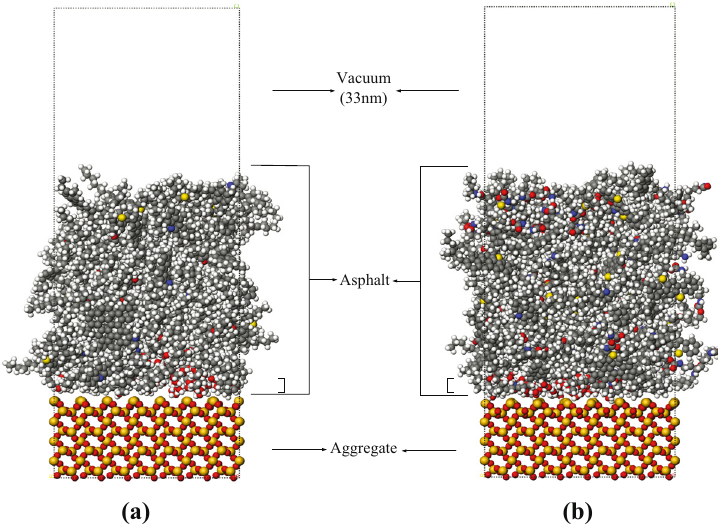
Figure 9: Interface model of asphalt and aggregate after dynamic calculation: ( a ) original asphalt – water – aggregate and ( b ) PU - modi fi ed asphalt – water –